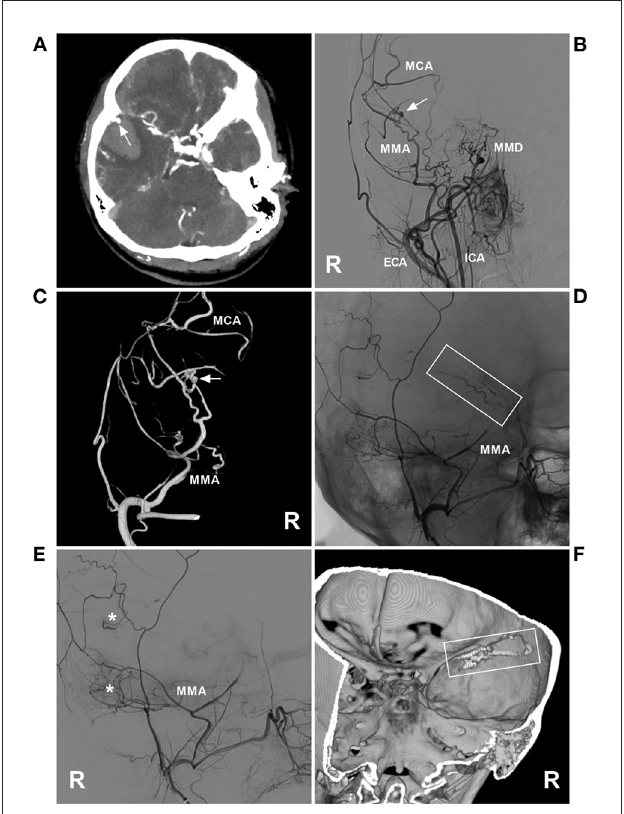
FIGURE3 PAO of the MMA aneurysm in case 11 in Table 1. (A) Enhanced CT showing hemorrhage of the temporal lobe. An aneurysm (arrow) is indicated at the rim of the hematoma. (B) DSA of the right carotid artery showing MMD in the ICA; an aneurysm (arrow) was at the MMA. (C) Three-dimensional DSA of the right ECA showing an aneurysm (arrow) at the transdural location of the MMA; then, the MCA was continued. (D) Unsubtracted DSA showing the MMA as the parent artery to the aneurysm was occluded with Onyx (frame). (E) DSA of the right ECA showing that the petrous branch of MMD had anastomoses (asterisks) with the MCA. (F) Xper-CT showing the location of Onyx casting (frame). CT, computed tomography; DSA, digital subtracted angiography; ECA, external carotid artery; ICA, internal carotid artery; MCA, middle cerebral artery; MMA, middle meningeal artery; MMD, moyamoya disease; R, right.